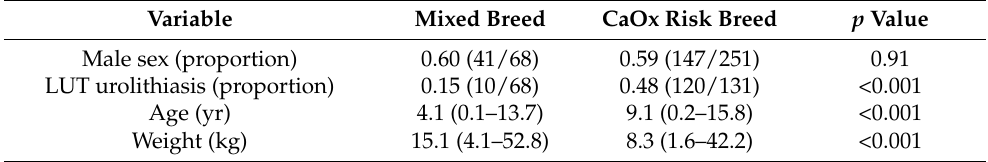
Table 1. Sex distribution, age (median) and weight (median) for the study dogs, including 68 mixed breed dogs and 251 dogs of breeds reported having increased risk for calcium oxalate (CaOx) uroliths. Variable Mixed Breed CaOx Risk Breed p Value Male sex (proportion) 0.60 (41/68) 0.59 (147/251) 0.91 LUT urolithiasis (proportion) 0.15 (10/68) 0.48 (120/131) <0.001 Age (yr) 4.1 (0.1–13.7) 9.1 (0.2–15.8) <0.001 Weight (kg) 15.1 (4.1–52.8) 8.3 (1.6–42.2)